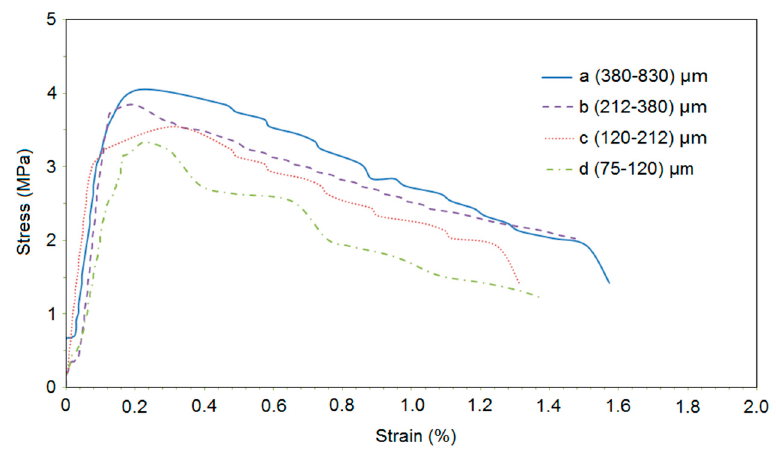
Figure 8. Relationship between stress and strain. Materials 2020 , 13 , x FOR PEER REVIEW